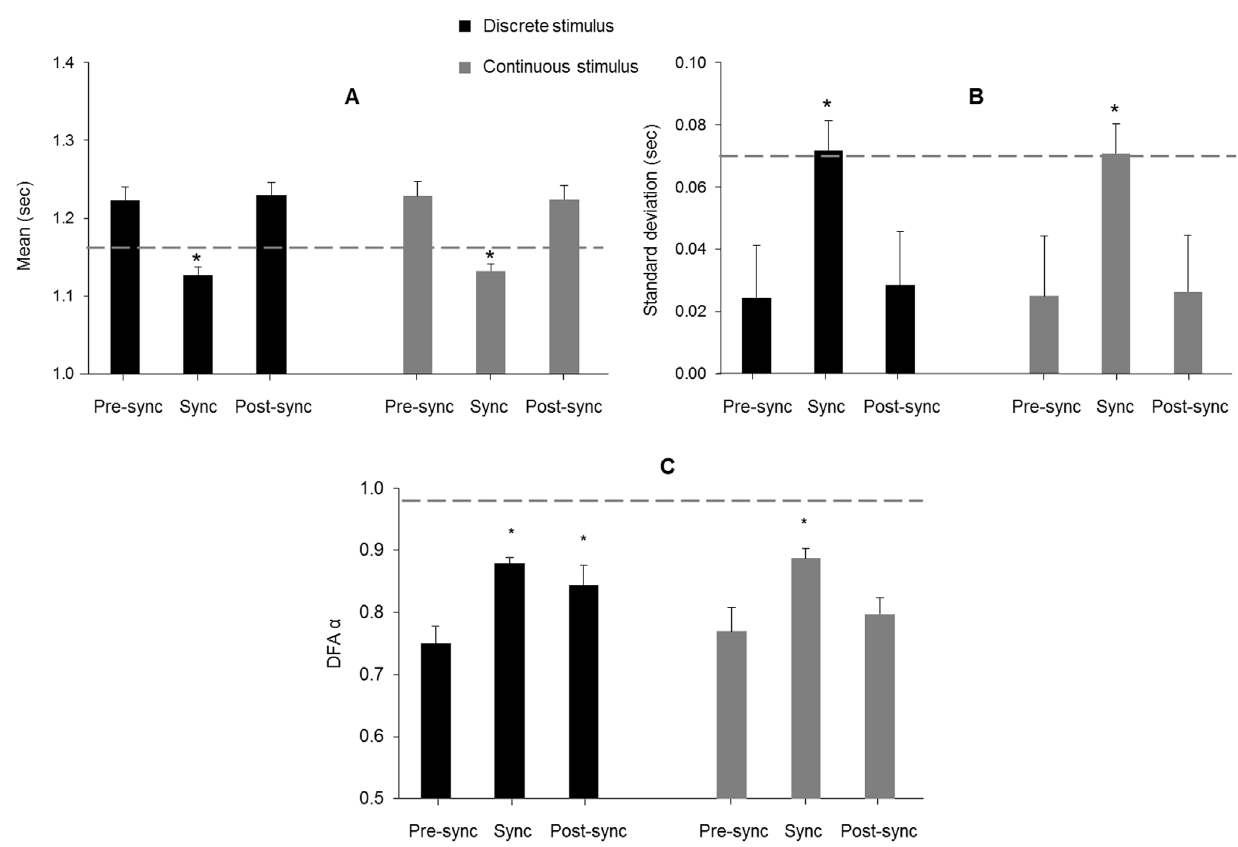
Figure 5. Mean, standard deviation, and DFA a of the stride interval time series in Experiment 2. A significant decrease in mean (A) and increase in standard deviation (B) was observed during the synchronization phase with both the discrete and continuous stimuli. The dashed gray line indicates the mean (1.17 sec) and standard deviation (0.07 sec) of the fractal stimulus that was used during the synchronization phase. Error bars represent standard error. Asterisks indicate the sync phase was significantly different relative to the pre- and post-sync phases. A significant increase in DFA a (C) was observed in the synchronization phase for both stimuli. However, only the discrete stimulus (black bars) led to the retention of the trained fractal structure, while the continuous stimulus (gray bars) did not lead to retention. The dashed gray line indicates the DFA a value (0.98) of the fractal stimulus that was used during the synchronization phase. Asterisks indicate the sync and post-sync phases were different than the pre- sync phase with the discrete stimulus, but only the sync phase was elevated with the continuous stimulus.